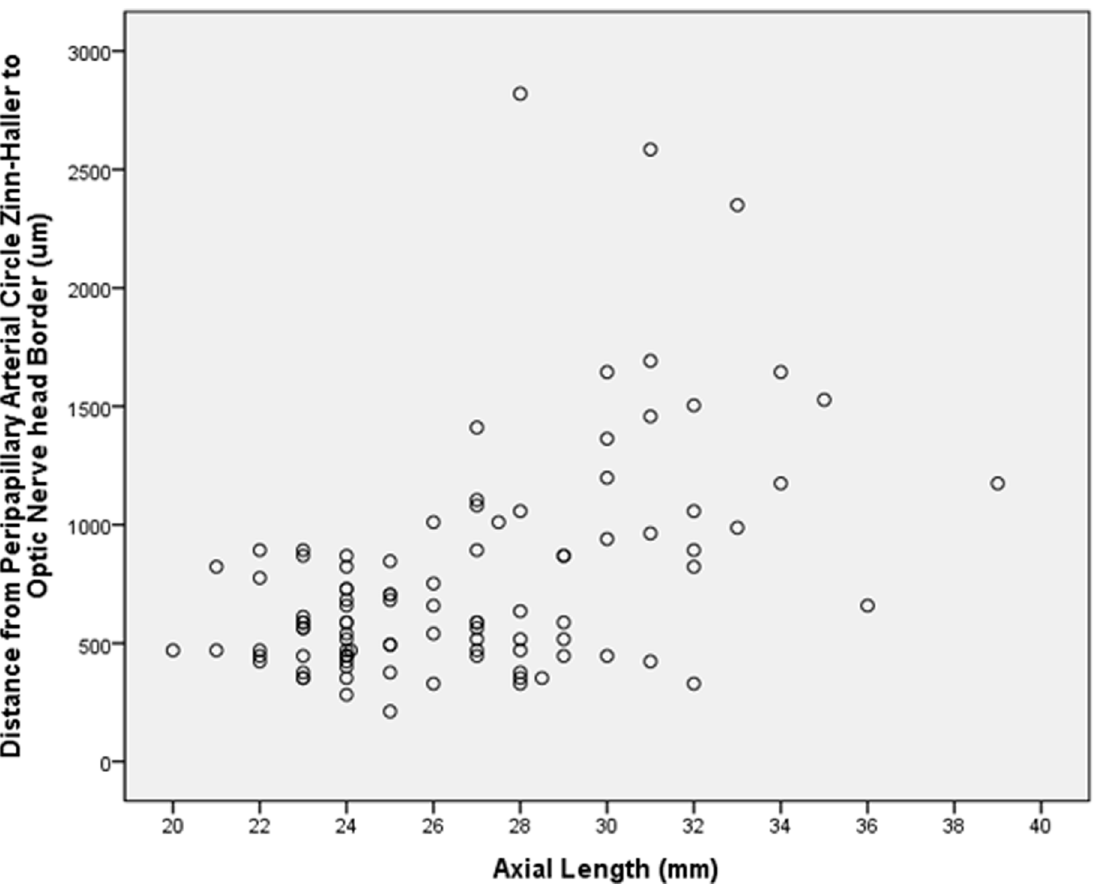
Figure 3. Graph showing the distribution of the distance between the peripapillary arterial circle of Zinn-Haller and the peripapillary ring in relation to axial length.